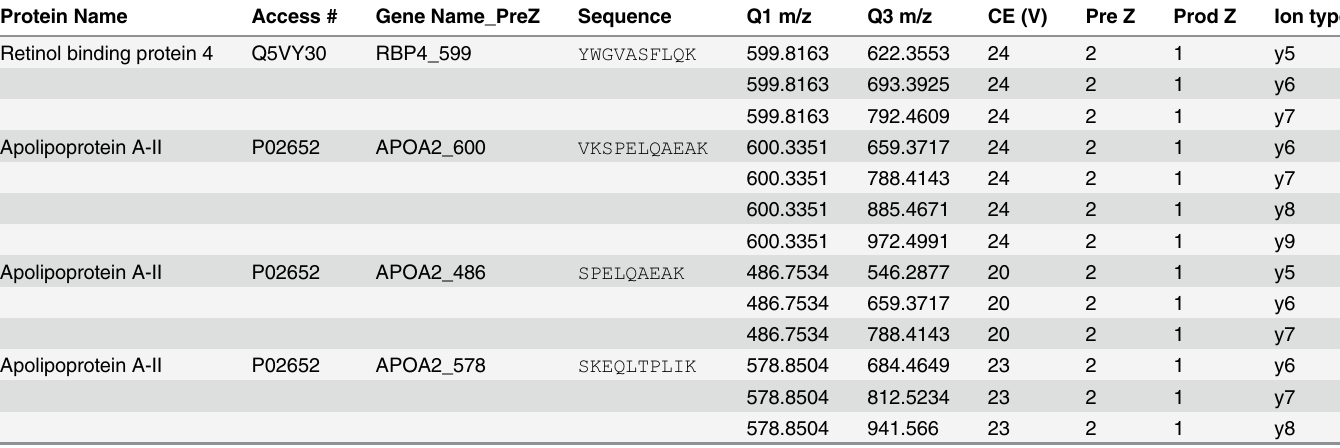
Table 5. SID-SRM-MS assays for BAP